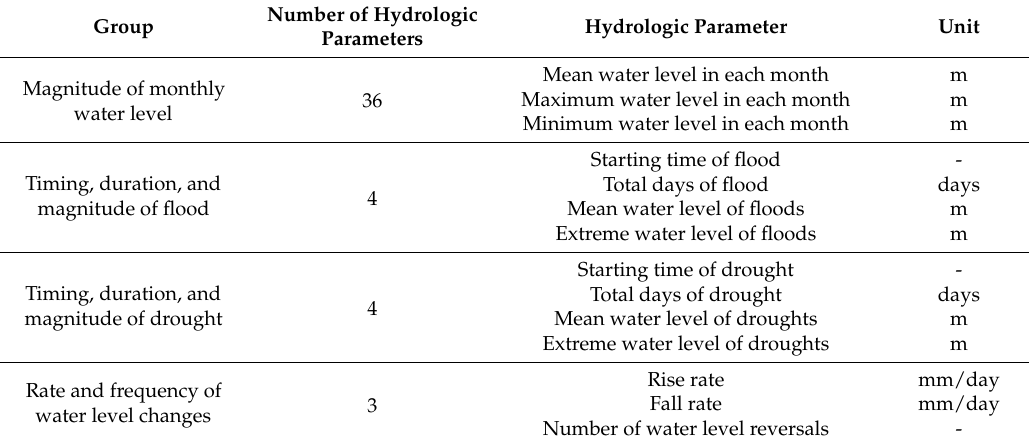
Table 1. Water level